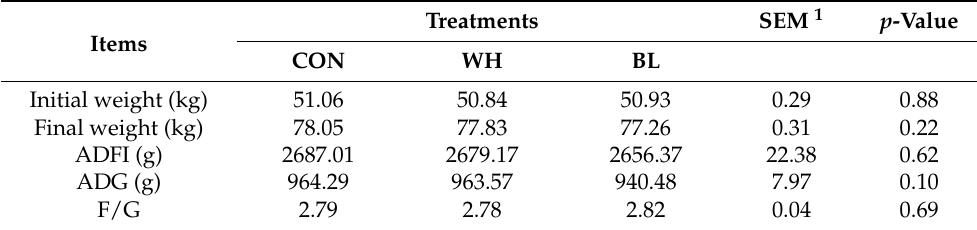
Table 2. Effects of the partial substitution of corn by wheat or barley on the growth performance of growing pigs.